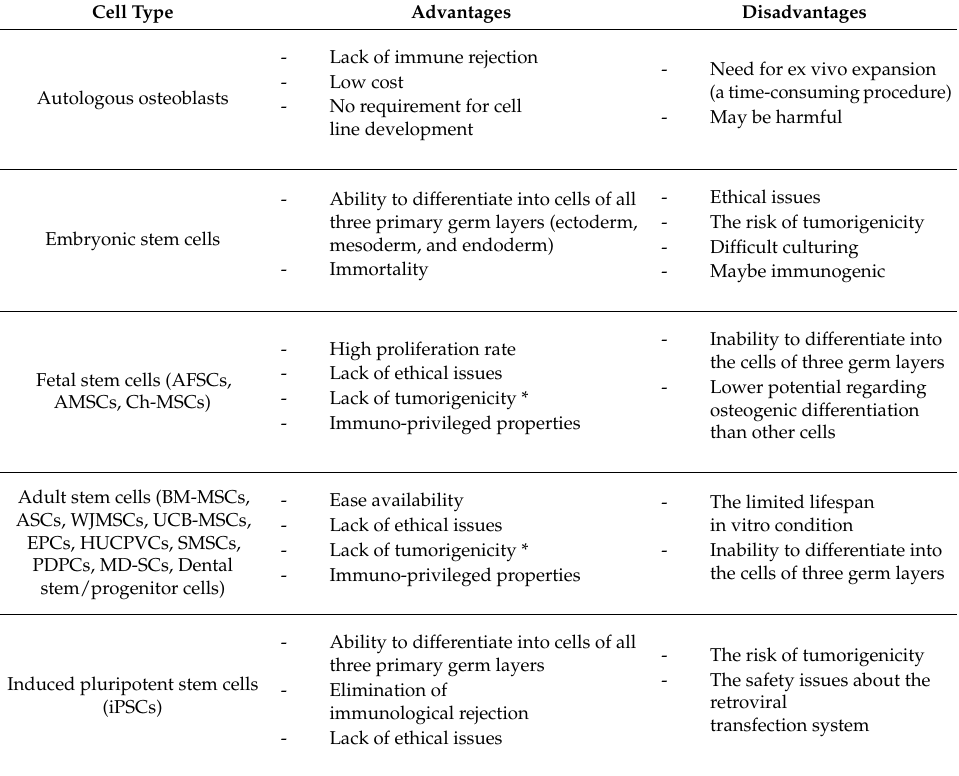
Figure 1. The cell niche within the bone tissue. Osteoblasts, osteocytes, osteoclasts, mesenchymal cells, and endothelial cells of blood vessels create the niches and contribute to the maintenance and differentiation of hematopoietic stem cells (HSCs). With permission from Reference [26]. Table 1. Overview of the somatic and stem cells used in BTE applications.